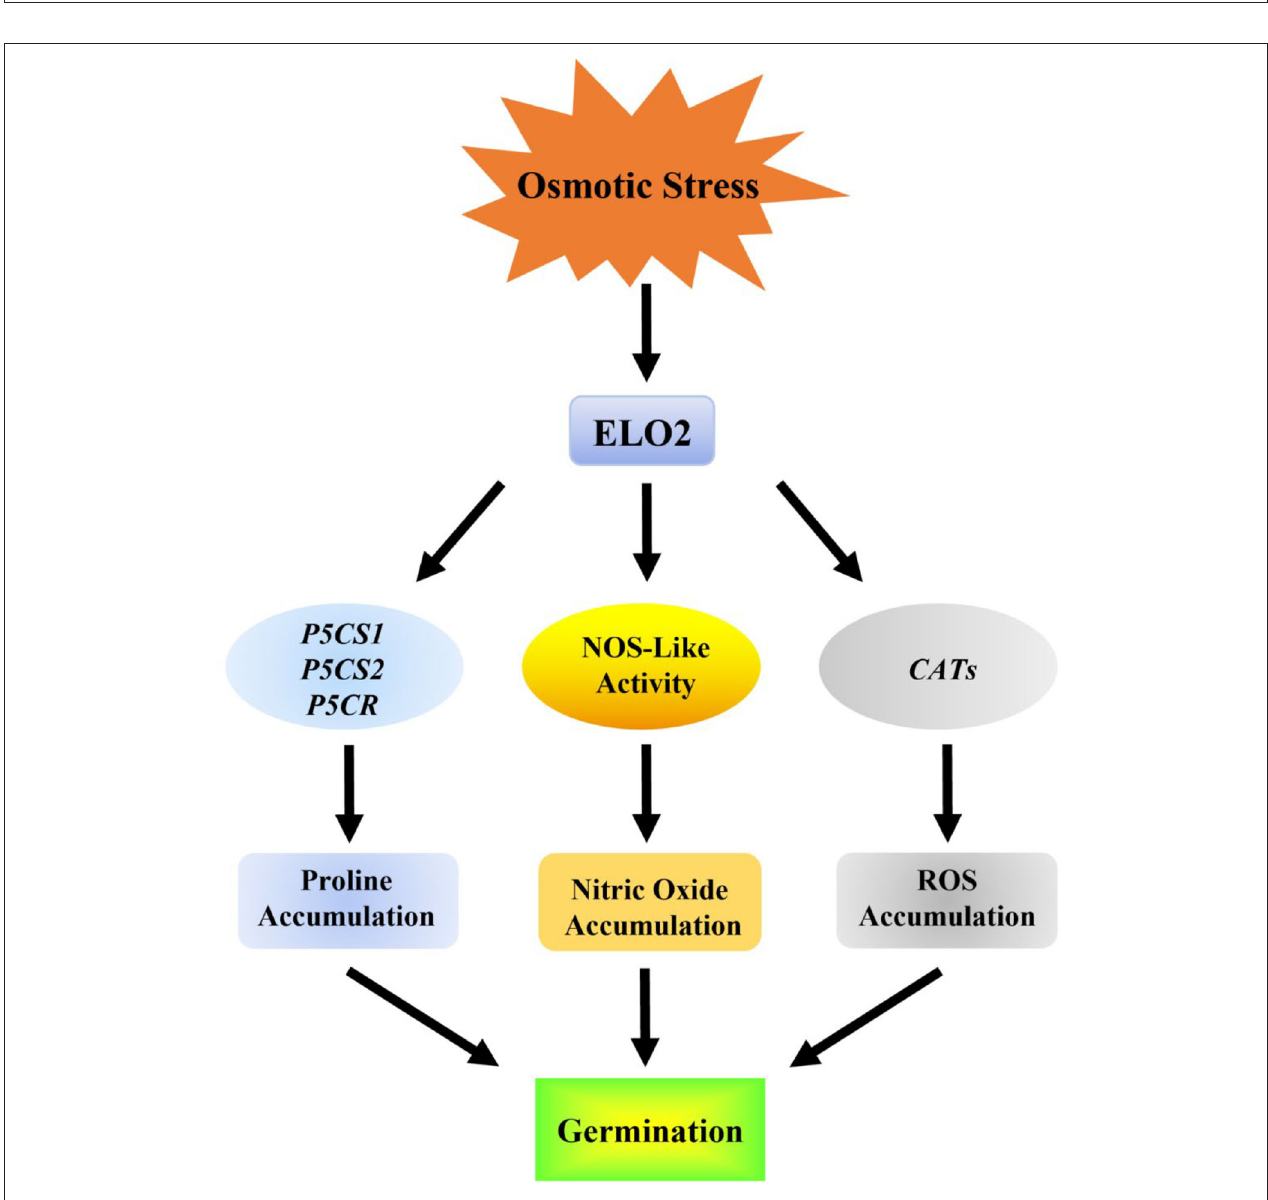
FIGURE 6 | Model for the role of ELO2 in response to osmotic stress in